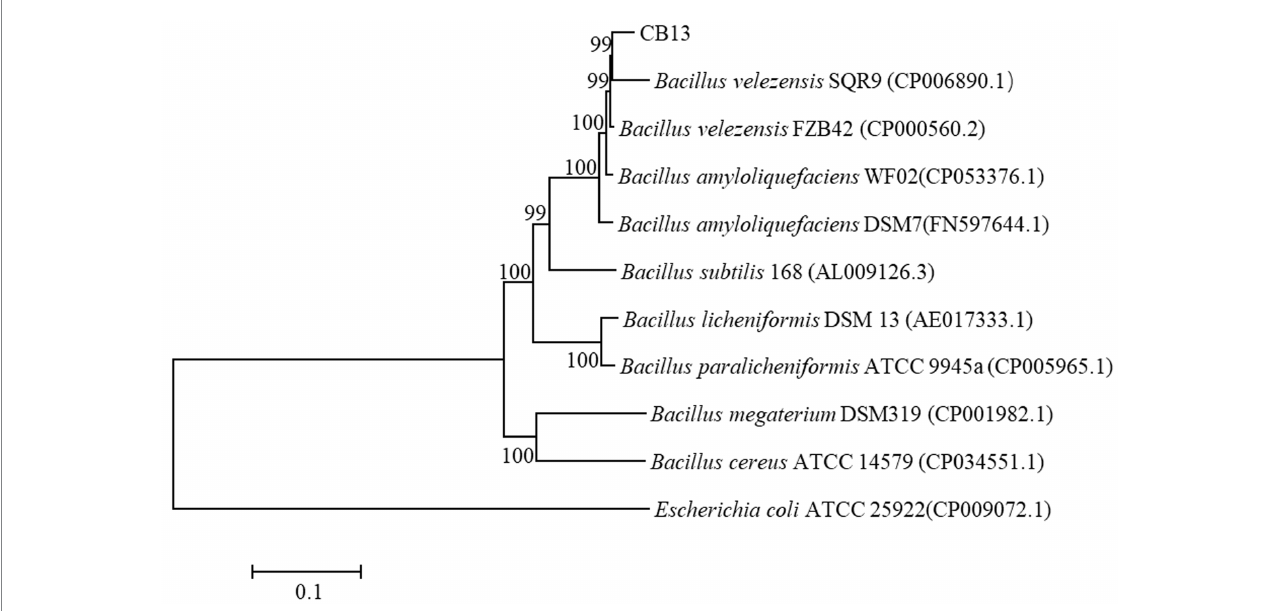
FIGURE 2 Phylogenetic trees based on the 16S rDNA, gyrA gene, gyrB gene, and rpoB gene sequences. The phylogenetic trees were constructed with the neighbor- joining method using the software package Mega, version 6.0, after multiple sequence alignments using Clustal X. GenBank accession numbers of bacterial strains are shown in parentheses. The number at each branch is the percentage of times the group of strains in that branch occurred, based on 1,000 cycles, via bootstrap